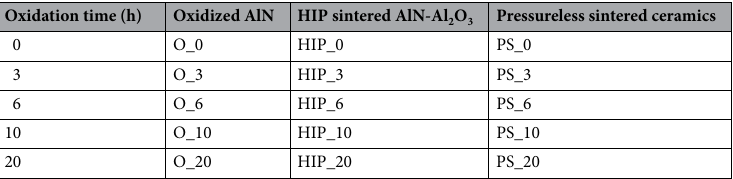
Table 1. Identification of samples after each preparation processes.